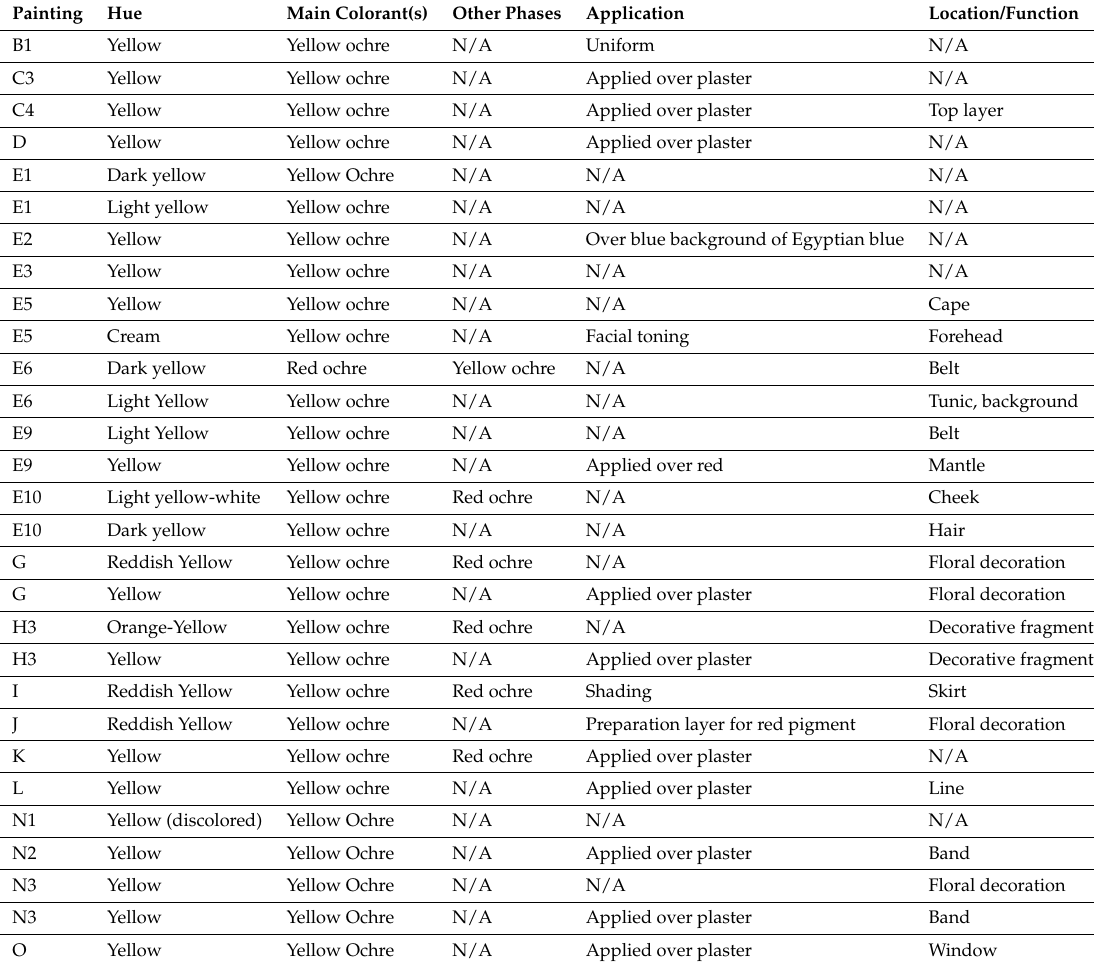
Table A4. Detailed list of the identification and application methodology of yellow ochre in the Cypriot wall